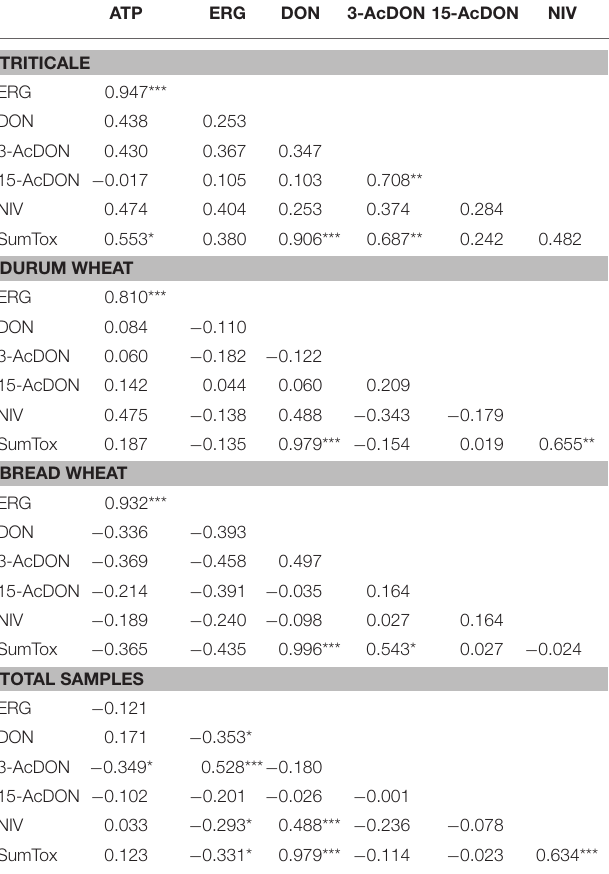
TABLE 2 | Coefficients of Pearson correlations between ATP, ERG, and trichothecene mycotoxins for three cereals ( n = 16) and for all ( n = 48) analyzed cereals samples